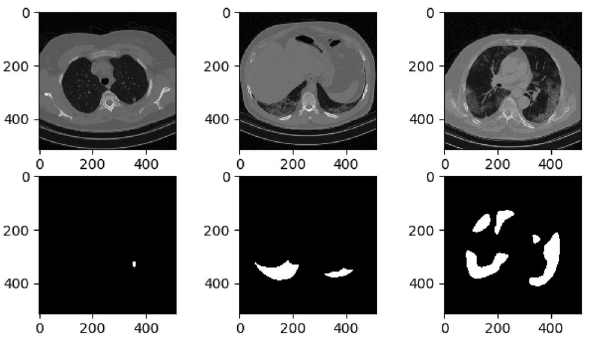
Figure 6. Examples of CT images with various infection rates and different positions in lung volume. First row: CT images. Second row: Ground truth masks.